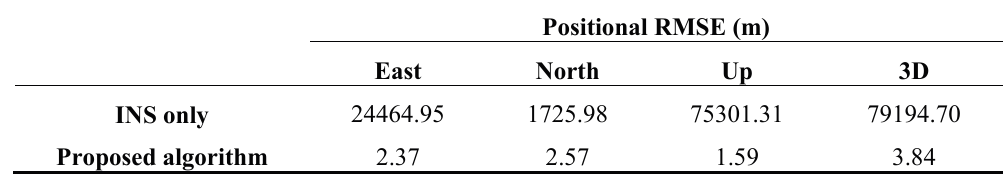
Table 2. The statistical analysis of positional errors for land test.